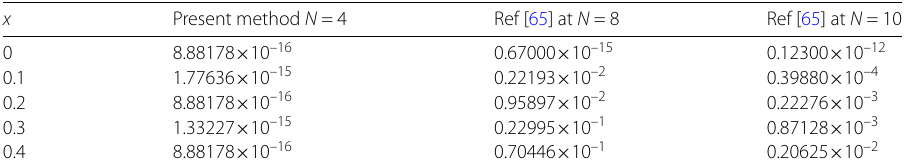
Table 1 Comparison of the absolute errors for Example 4 for different N values at ν 2 = 2